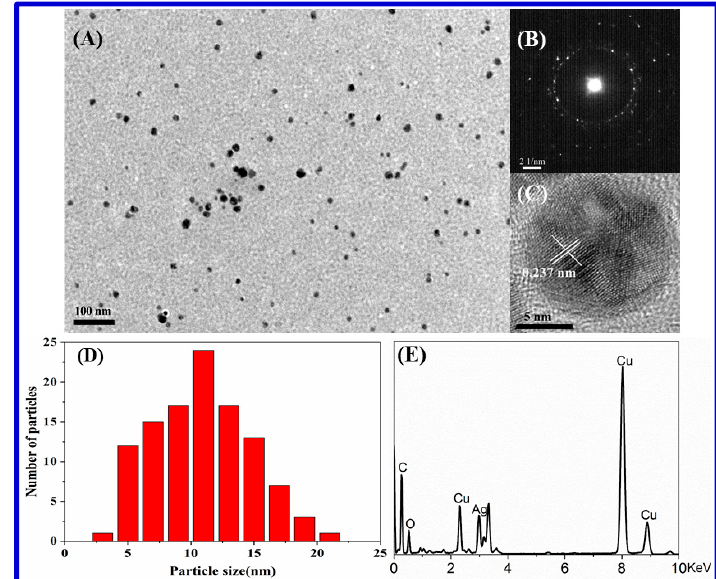
Figure 2. ( A ) TEM image, ( B ) HR-TEM image, ( C ) selected area electron diffraction (SAED) pattern, ( D ) the size distribution histogram and ( E ) energy dispersive X-ray spectroscopy (EDS) spectrum of AgNPs. (Reaction condition of AgNPs is 0.5% carrageenan, 1 mM AgNO 3 , 90 °C, 4 h).